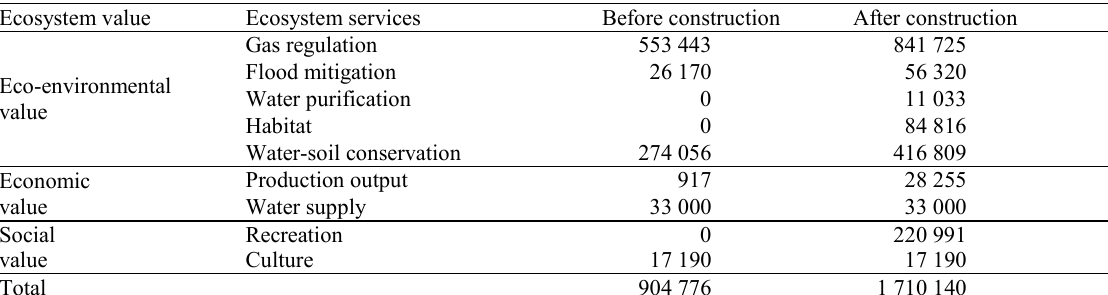
Table 2 The results of wetland benefit value before and after construction (RMB). Ecosystem value Ecosystem services Before construction After